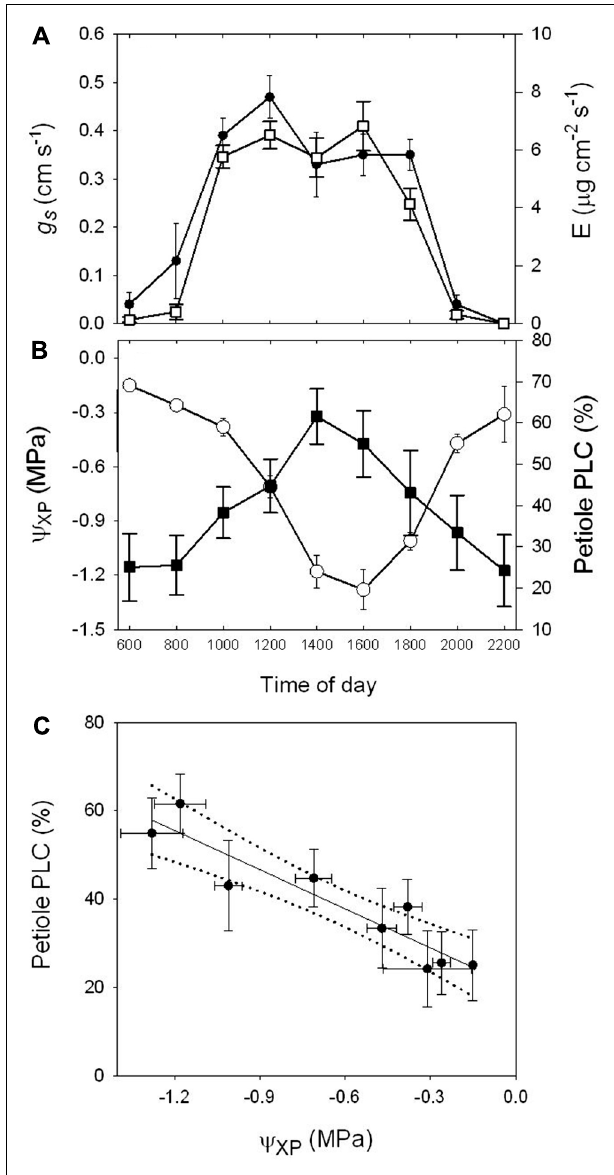
FIGURE 1 | (A) Diurnal trends in stomatal conductance ( g s , n = 15) and transpiration rate ( E , n = 15), (B) covered leaf water potential ( ψ xp, n = 10) and the percent loss in hydraulic conductance of petioles (PLC, n = 10) of A. rubrum measured on a sunny day from mature trees. (C) Regression analysis of PLC pet to ψ xp ( y = − 29.47 x + 20.14, R 2 = 0.87) of data from (B) . Each data point represents the pooled average values measured from three mature trees located near each